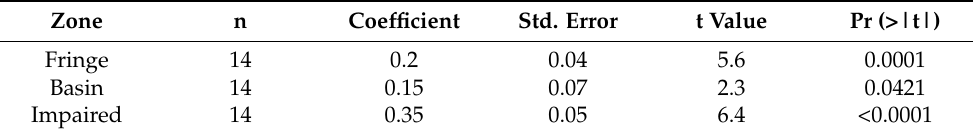
Table 2. The effect of the flooding time over sulfide concentrations in the fringe, basin, and impaired mangrove forests.